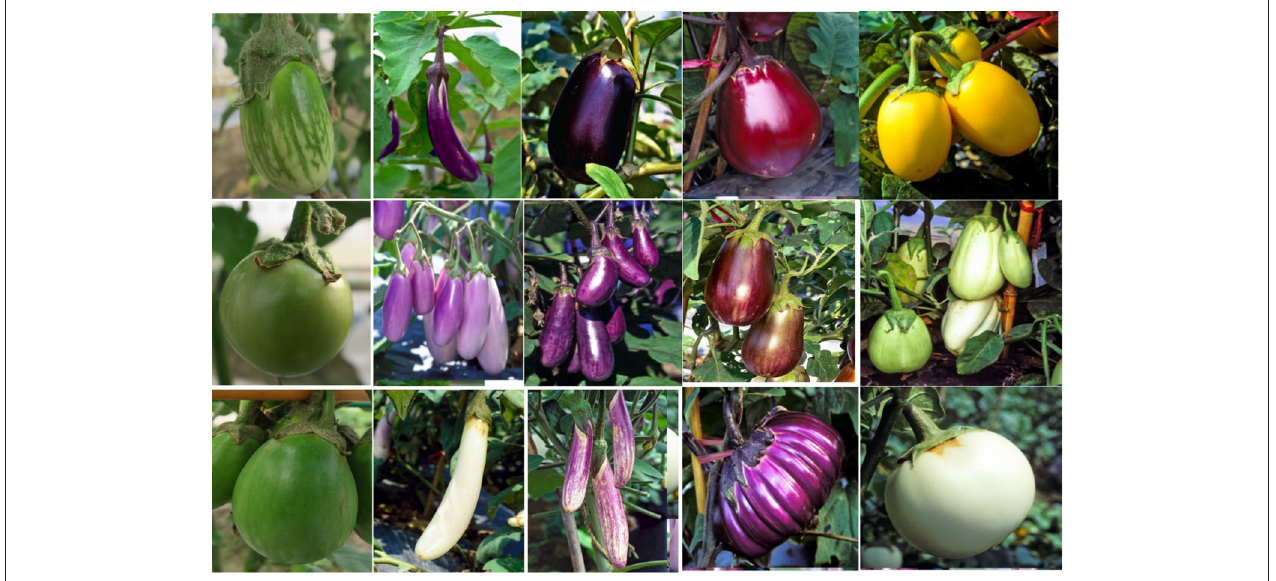
FIGURE 3 | Different fruit shapes, colors, and sizes of Solanum melongena accessions in the World Vegetable Center germplasm collection.